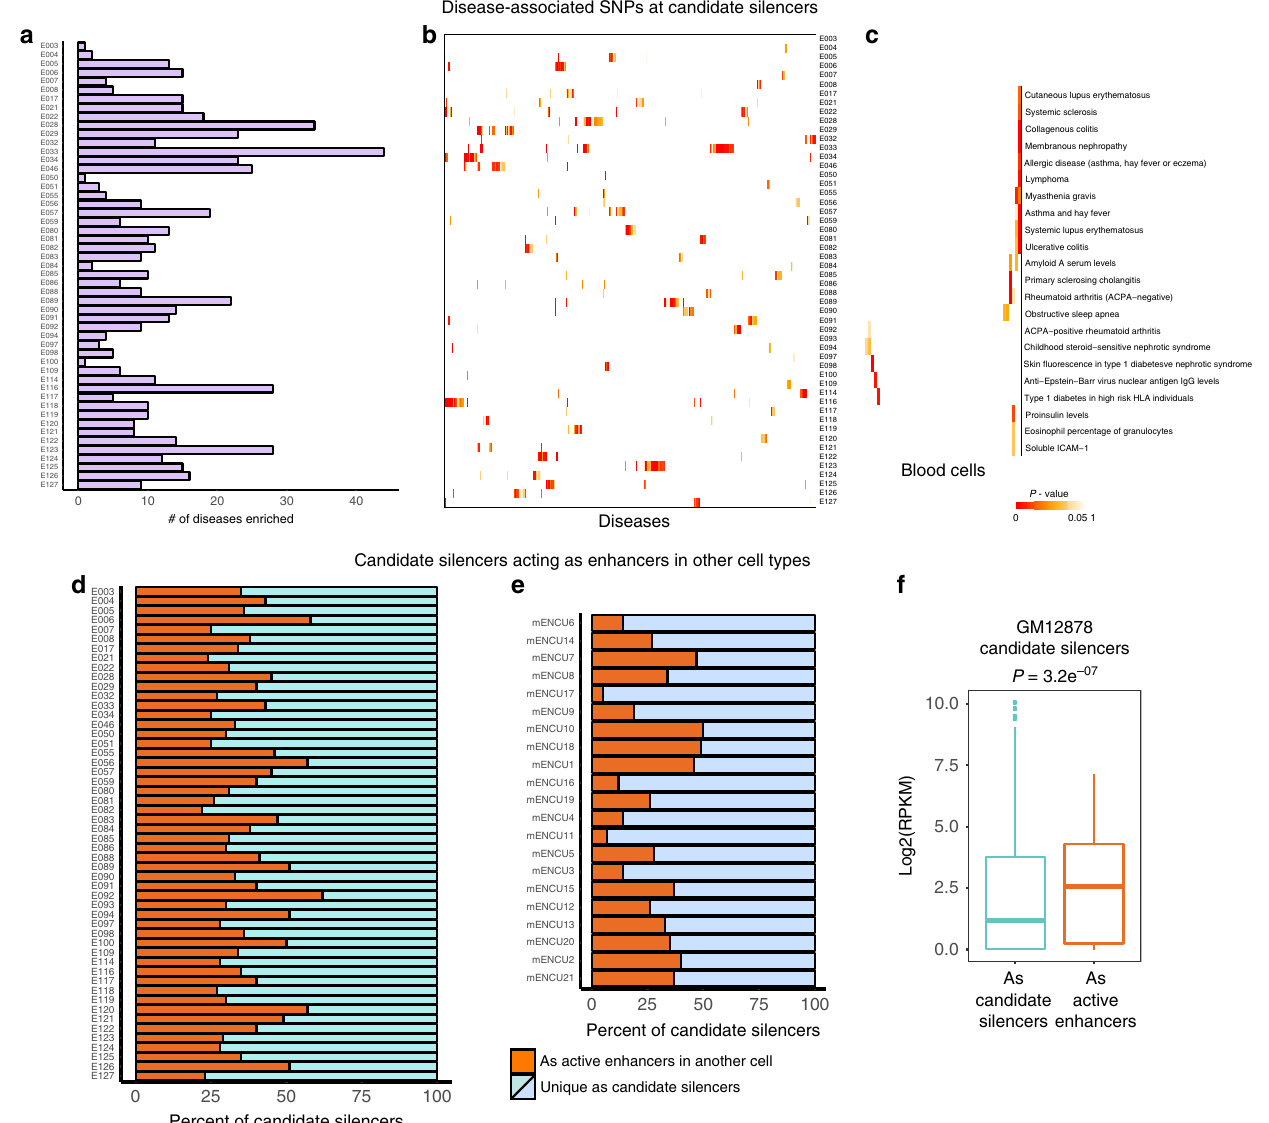
Fig. 6 Candidate silencer elements are enriched for GWAS SNPs and can act as enhancers in other cell types. a Bar plot presenting the count of GWAS SNPs belonging to various disease traits enriched (adj. P -value < 0.01) at candidate silencer elements of 52 cell types and tissues from Roadmap. b Heatmap of enrichment (-log10( P -value)) of 451 disease traits SNPs across 52 cell types. Columns represent disease traits and rows are cell types. c Heatmap of SNP enrichment (-log10( P -value)) for autoimmune disease traits across blood cell types. Bar plot showing the fraction of candidate silencer elements identi fi ed in one cell type acting as enhancers in other cell types for human Roadmap data ( d ) and mouse ENCODE data ( e ). f An example of GM12878 silencers acting as enhancers in CD34 + cells. Box plot comparing the expression distribution of interacting genes. P -values computed by one-tailed Wilcoxon rank-sum test. In the box plots, bounds of the box spans from 25 to 75% percentile, center line represents median, and whiskers visualize 5 and 95% of the data